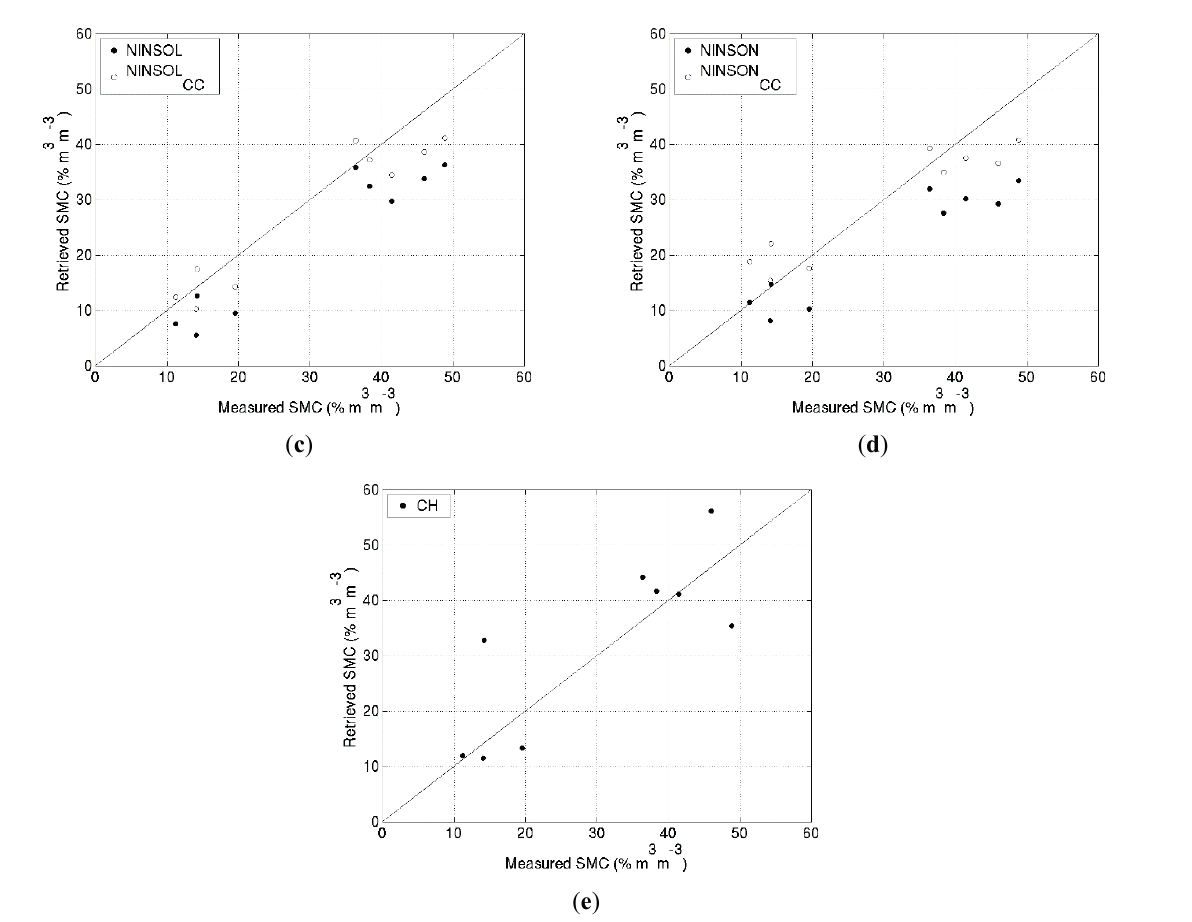
Figure 11. Retrieved soil moisture content (SMC) from each criteria fit versus in-situ measured